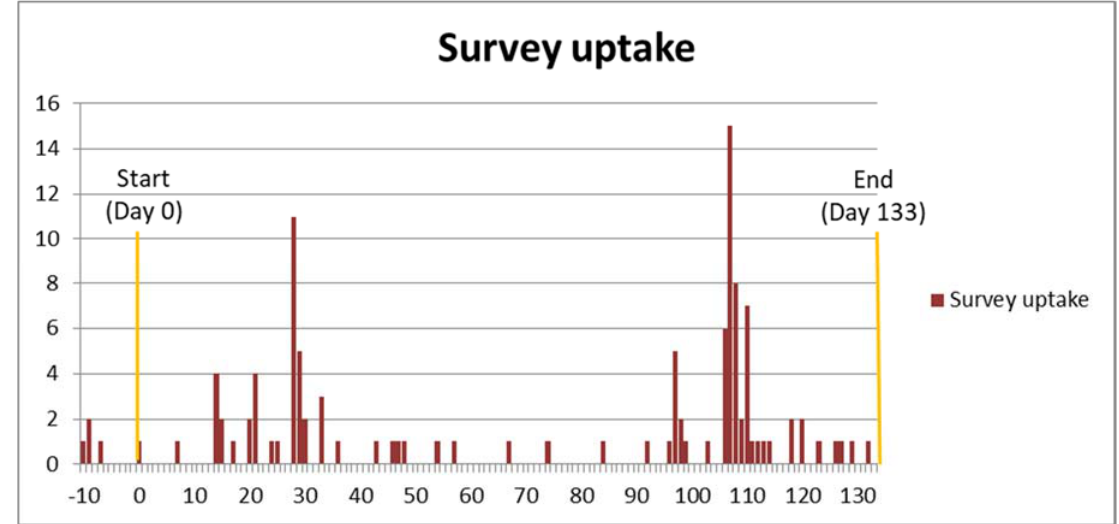
Figure 1. Survey uptake over time, showing the effects of the reminder sent five weeks before closure.